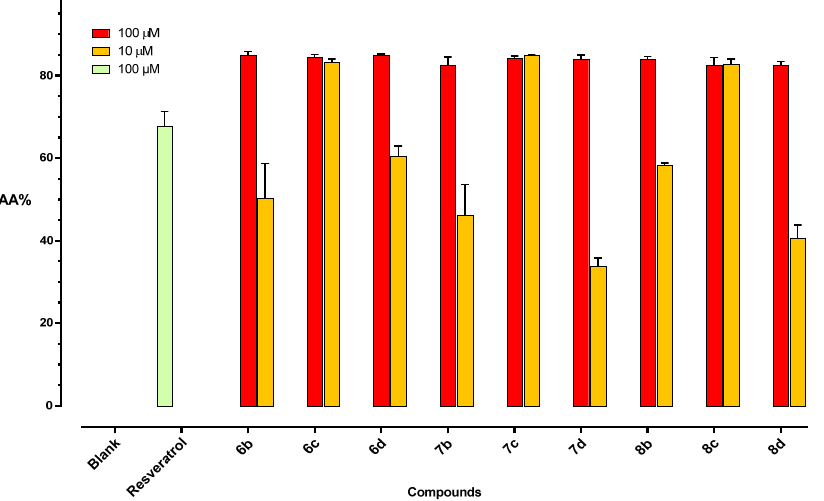
Figure 3. Radical scavenging capacity of ( E )-benzaldehyde O -benzyl oximes 6b–d 7b–d , 8b–d , and resveratrol, expressed as a percentage of anti-oxidant activity (AA%).